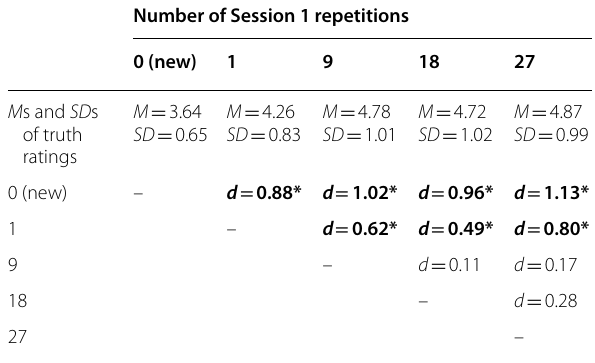
Table 2 Experiment 2 truth ratings as a function of repetition condition and the pairwise comparison effect sizes between repetition